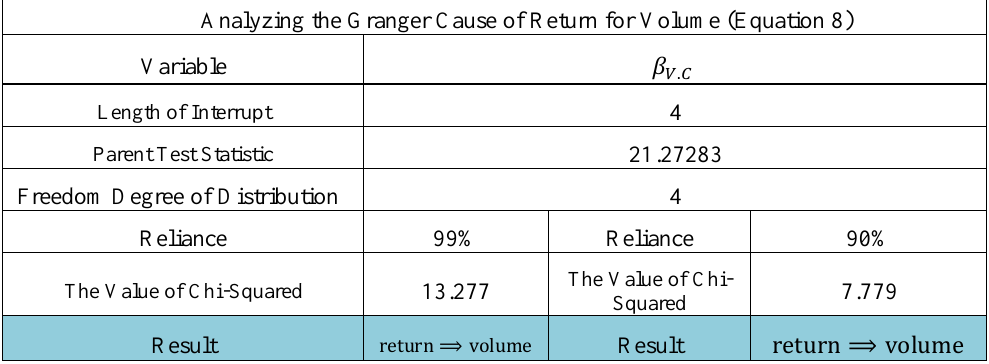
Table 2. The Estimation Results of the Conditional Mean Volume